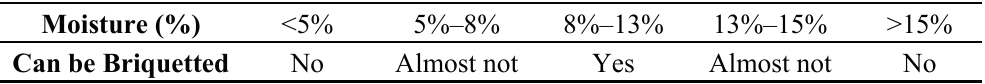
Table 2. Effect of moisture content on raw residue